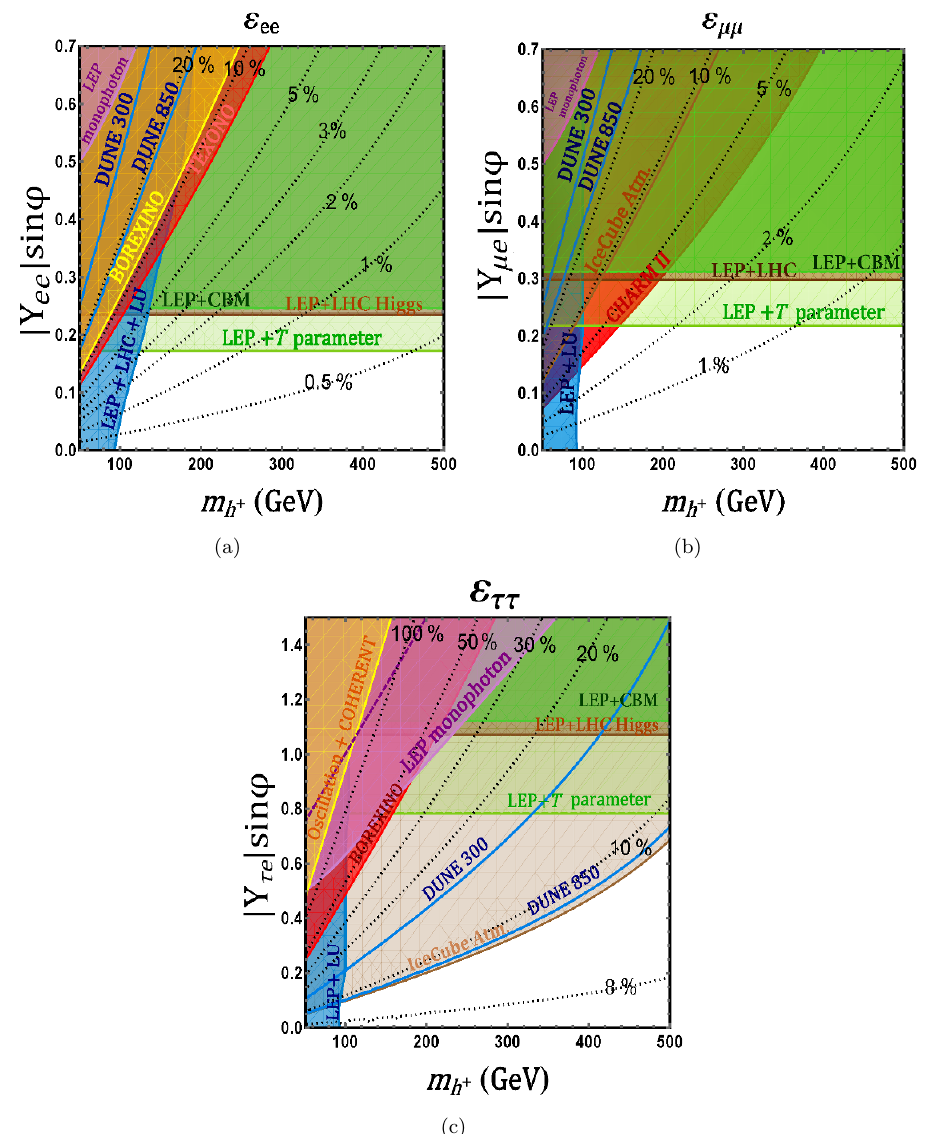
Figure 18 . Zee model predictions for diagonal NSI ( " ee ; " (cid:22)(cid:22) ; " (cid:28)(cid:28) ) are shown by the black dot- ted contours. Color-shaded regions are excluded by various theoretical and experimental con- straints: blue-shaded region excluded by direct searches from LEP and LHC (section 4.7) and/or lepton universality (LU) tests in W decays (section 4.8); purple-shaded region by o(cid:11) Z -pole LEP monophoton search (cf. section 4.11), with the purple dashed line in (c) indicating a weaker limit from on Z -pole LEP search; light green, brown and deep green-shaded regions respectively by T parameter (section 4.4), precision Higgs data (section 4.10), and charge-breaking minima (sec- tion 4.3), each combined with LEP contact interaction constraint (section 4.6). In addition, we show the direct constraints on NSI from neutrino-electron scattering experiments (red/yellow-shaded), like CHARM [147], TEXONO [148] and BOREXINO [149], from IceCube atmospheric neutrino data [152] (light brown), as well as the global-(cid:12)t constraints from neutrino oscillation+COHERENT data [61] (orange-shaded). We also show the future DUNE sensitivity (blue solid lines), for both 300 kt.MW.yr and 850 kt.MW.yr exposure [66].